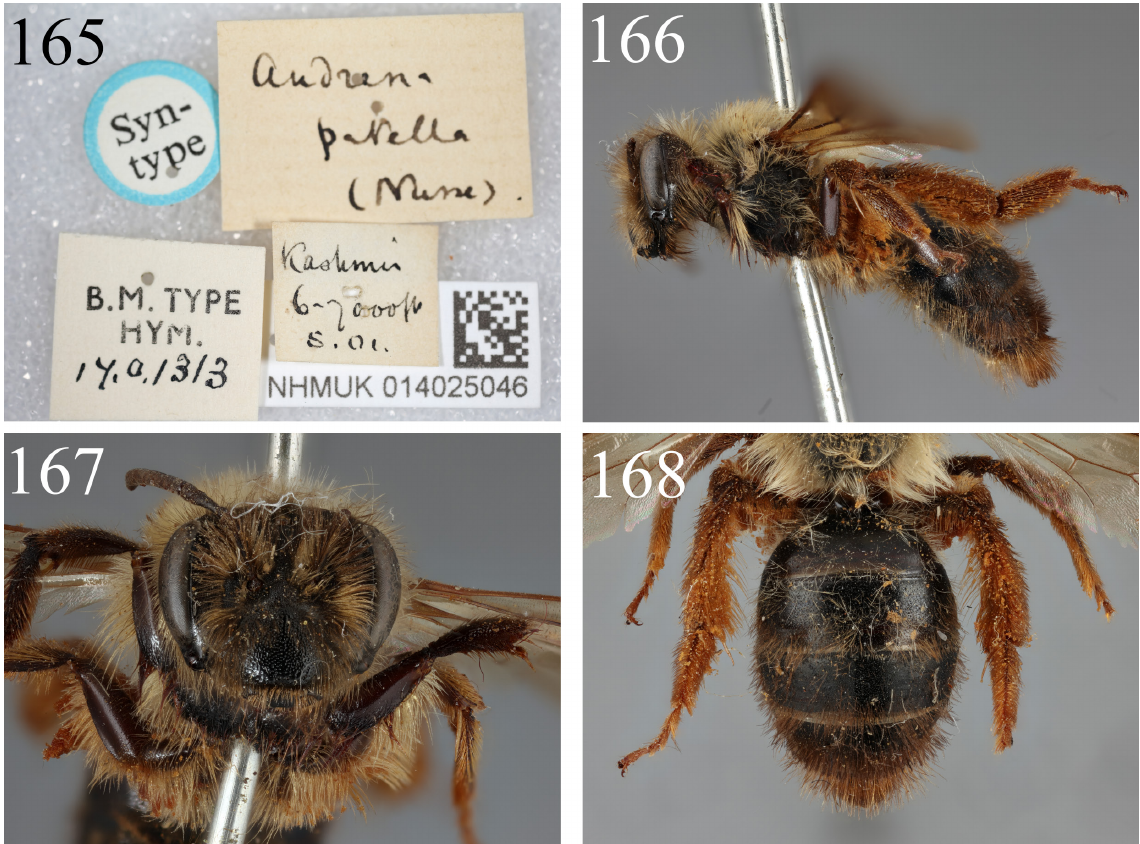
Figs 165–168. Andrena patella Nurse, 1903, ♀, syntype (NHMUK). 165 . Label information. 166 . Profile. 167 . Face. 168 .